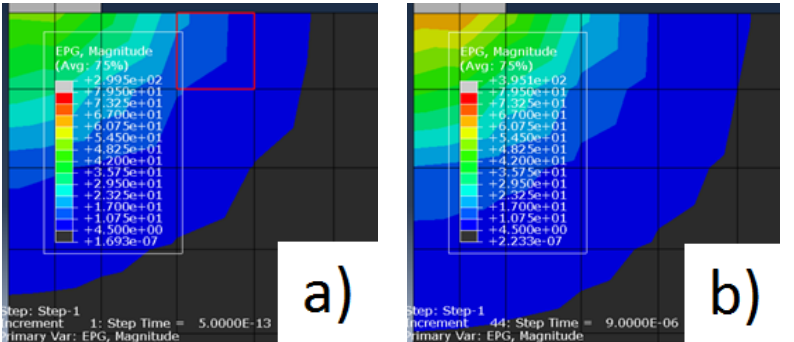
Figure 5. ( a ) Electrical potential gradient for the pulse of 18 µ s at the beginning of the discharge; ( b ) Electrical potential gradient for the pulse of 18 µ s at the end of the discharge.